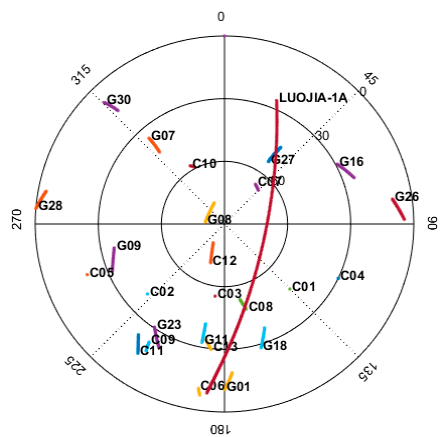
Figure 9. Representative sky plot of the Wuhan station shows the tracks of Luojia-1A and GPS/Beidou satellites over a 10 min pass.